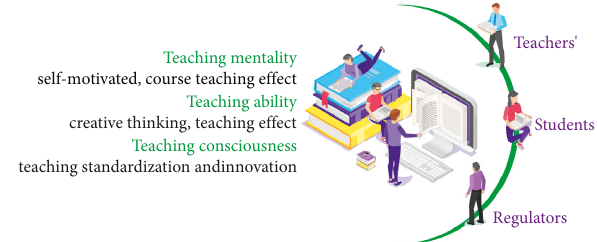
Figure 1: Relationship between subjects of teaching quality